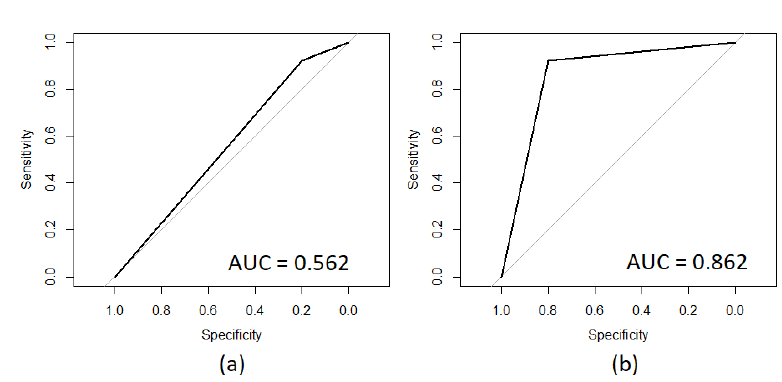
Figure 2. ROC curves obtained through ( a ) the model containing the complete set of features and ( b ) the model containing the set of features presenting an AUC value higher than